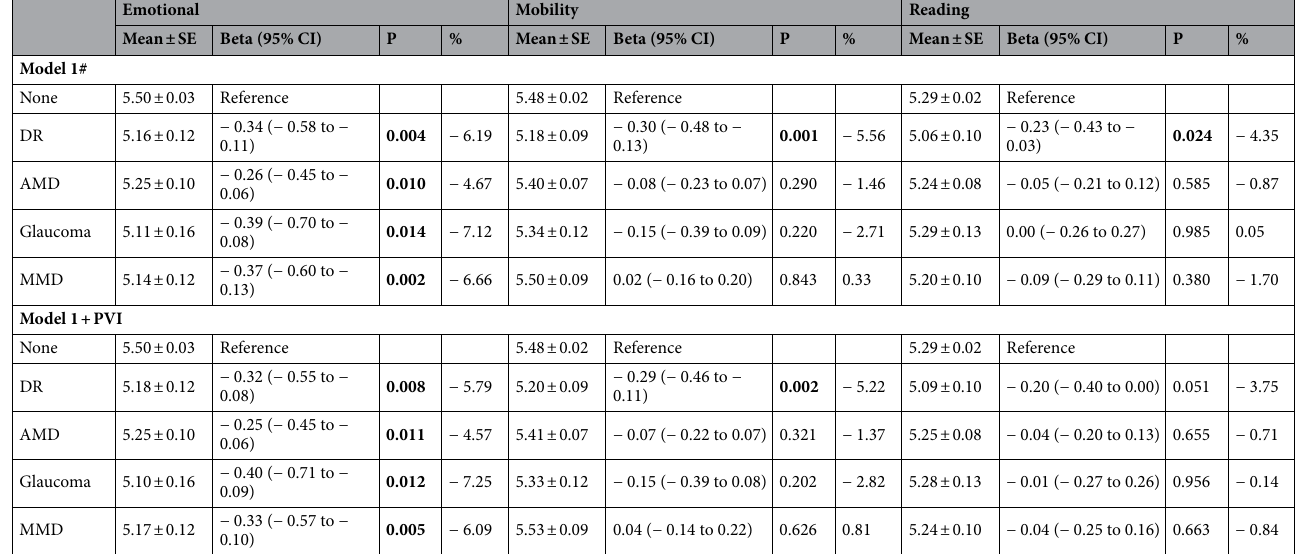
Table 2. Multivariable-adjusted association between eye disease and IVI scores in a multiple linear regression model. Systemic diseases include diabetes mellitus, arterial hypertension, hyperlipidaemia, CVD and CKD. BMI body mass index, CVD cardiovascular disease, CKD chronic kidney disease, PVI presenting visual impairment, DR diabetic retinopathy, AMD age related macular degeneration, MMD myopic macular degeneration. Significant values are in [bold]. # Adjusted for age, gender, race, education, income, housing, BMI, smoking status, alcohol use and presence of any systemic